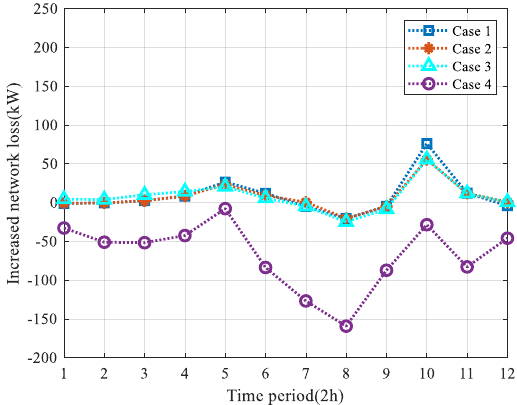
Figure 13. Increased network loss in four cases. Table 5. Network loss cost and energy loss cost in the four cases.